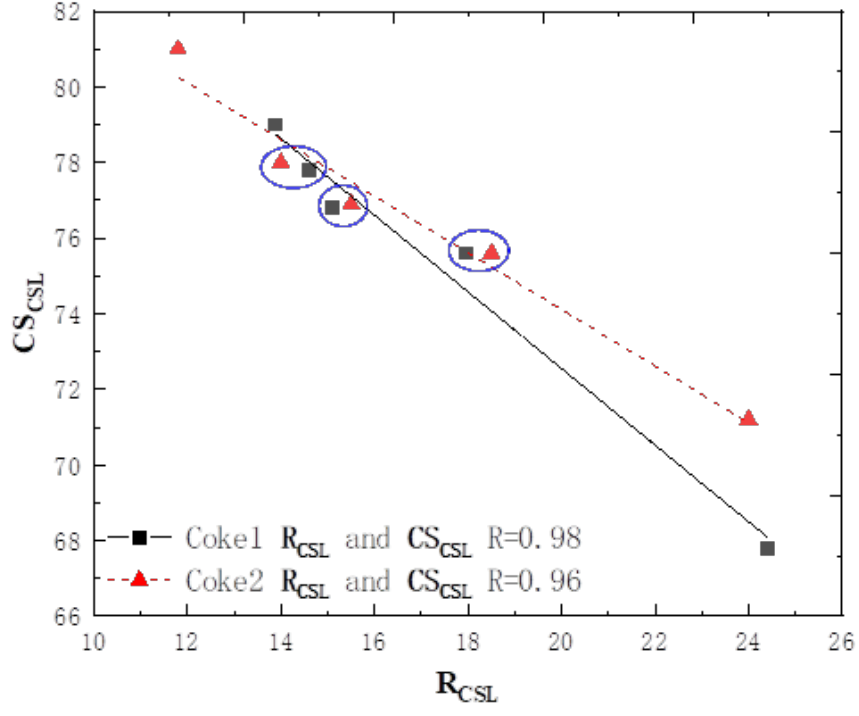
Figure 10. The linear fitting relationships between R CSL and CS CSL of high- and low-reactivity coke.